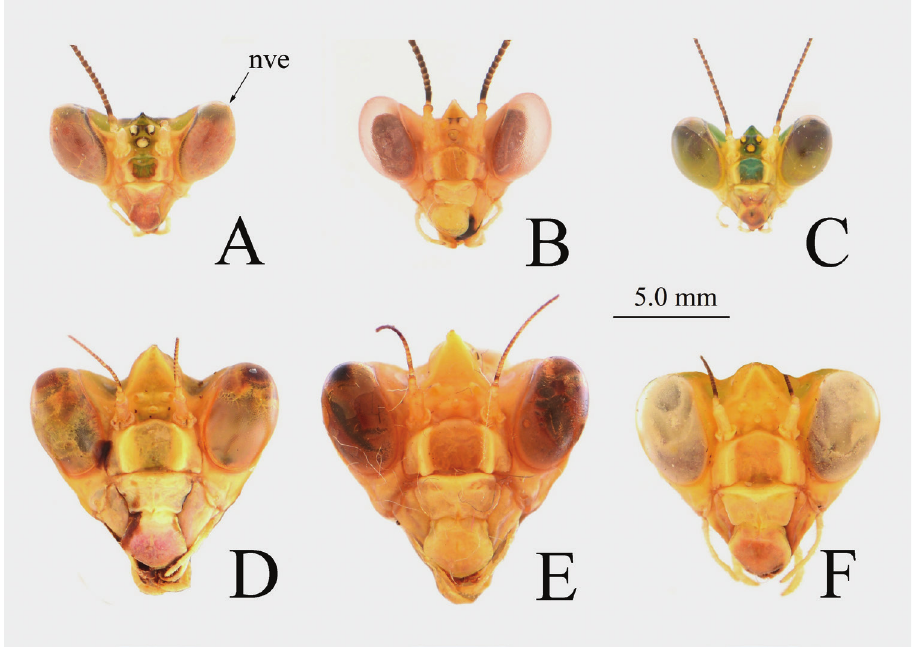
Figure 5. Head of Theopropus spp., anterior view A, D T. sinecus sinecus B, E T. xishiae sp. nov. C, F T. sp. A–C male D–F female. Abbreviations: nve = non-visual elongation.